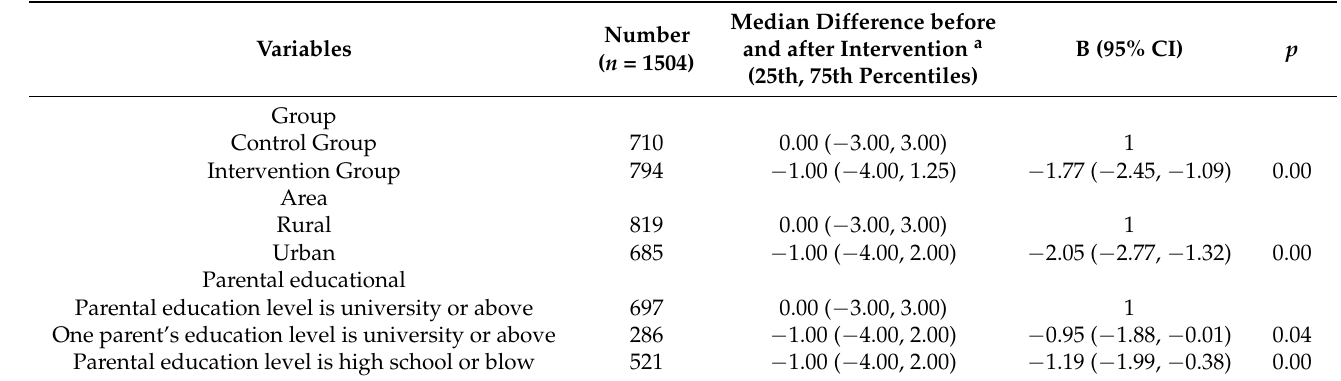
Table 7. Multivariate regression analysis of factors on improvement of sugar-sweetened beverages (SSBs)